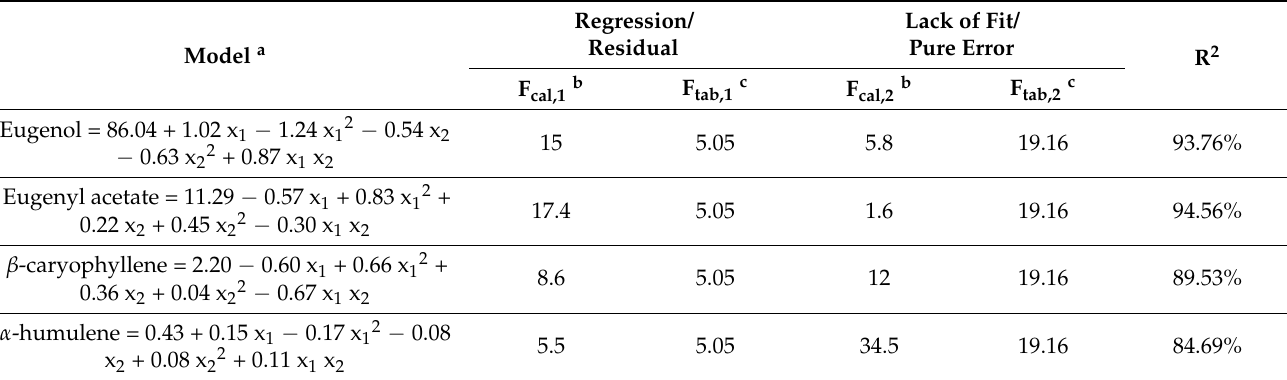
Table 4. Coded models and results of analysis of variance